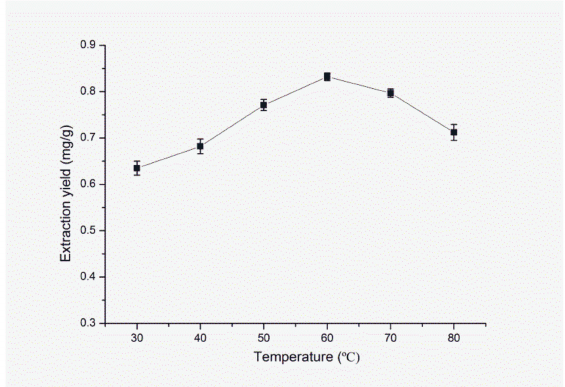
Figure 8. E ff ect of extraction temperature on extraction yield of FA. Sample amount, 50 mg; type of IL, [C 4 mim]NTf 2 ; solid–liquid ratio, 1:40 (g / mL); volume of IL 0.8 mL; ultrasonic time, 9 min; centrifugal speed, 11,000 rpm; centrifugal time, 5 min.